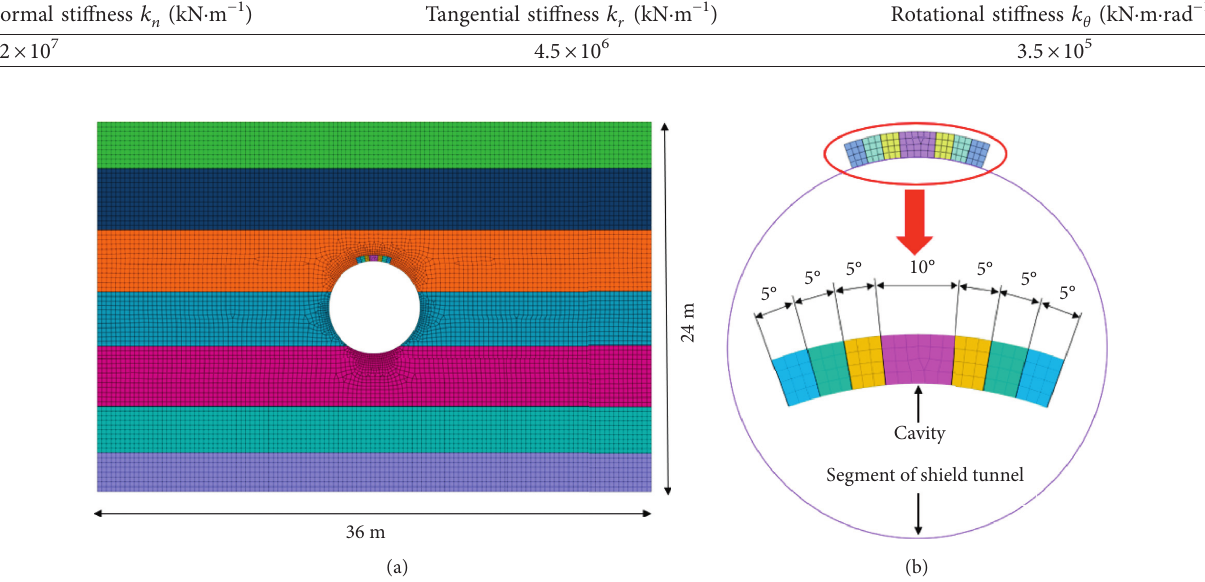
Figure 7: Finite element model diagram. (a) Overall view. (b) segment structure